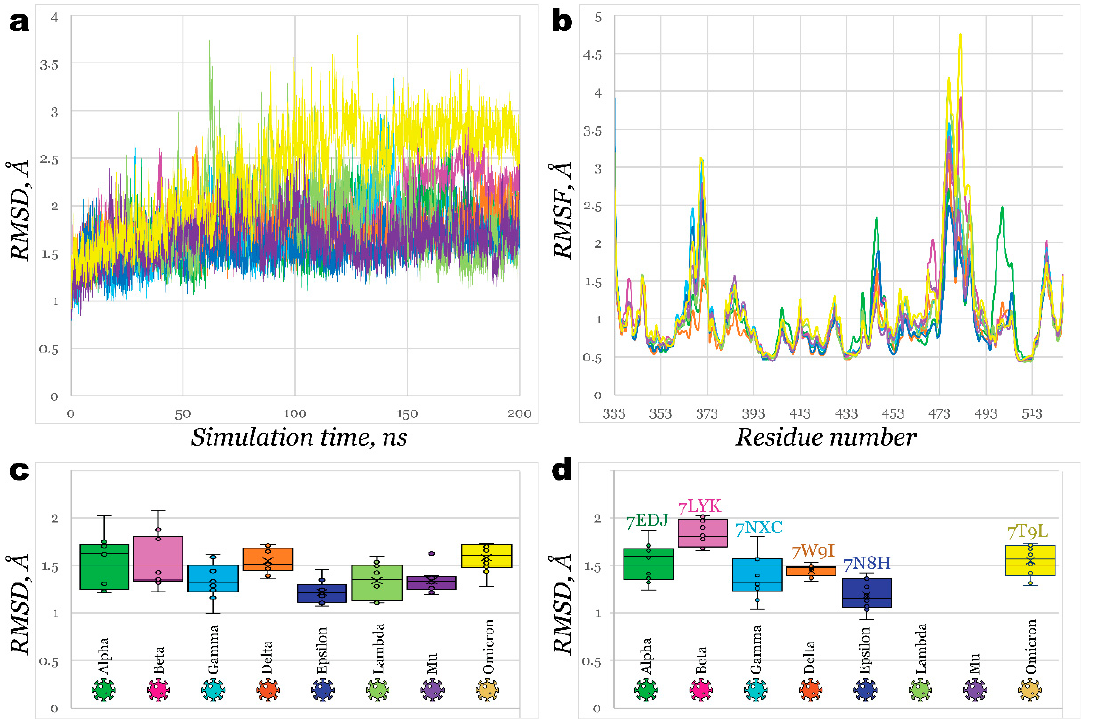
Figure 2. Homology models of SARS-CoV-2 variants’ RBDs: ( a )—RMSD of generated homology models for 200 ns molecular dynamics simulation; ( b )—RMSF of generated homology models for 200 ns molecular dynamics simulation; ( c )—Box and whiskers graph for 10 clusters of each generated homology model, derived from MD simulation, representing its RMSD aligned on Wild type RBD’s structure (PDB ID: 6M0J); ( d )—Box and whiskers graph for 10 clusters of generated homology models, representing each variant’s RMSD aligned on corresponding crystallographic structures.